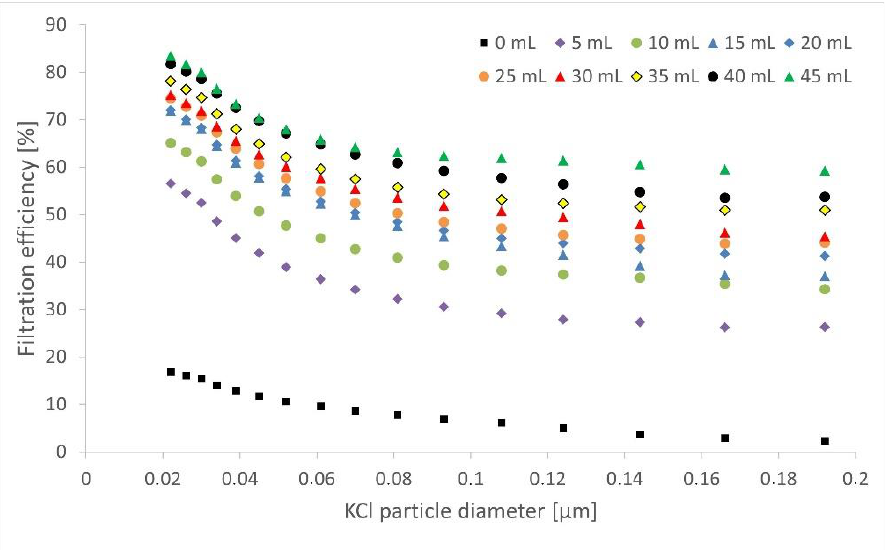
Figure 9. Dependence of the fractional filtration efficiency on the volume of 4% PLA solution used for the production of fibers.